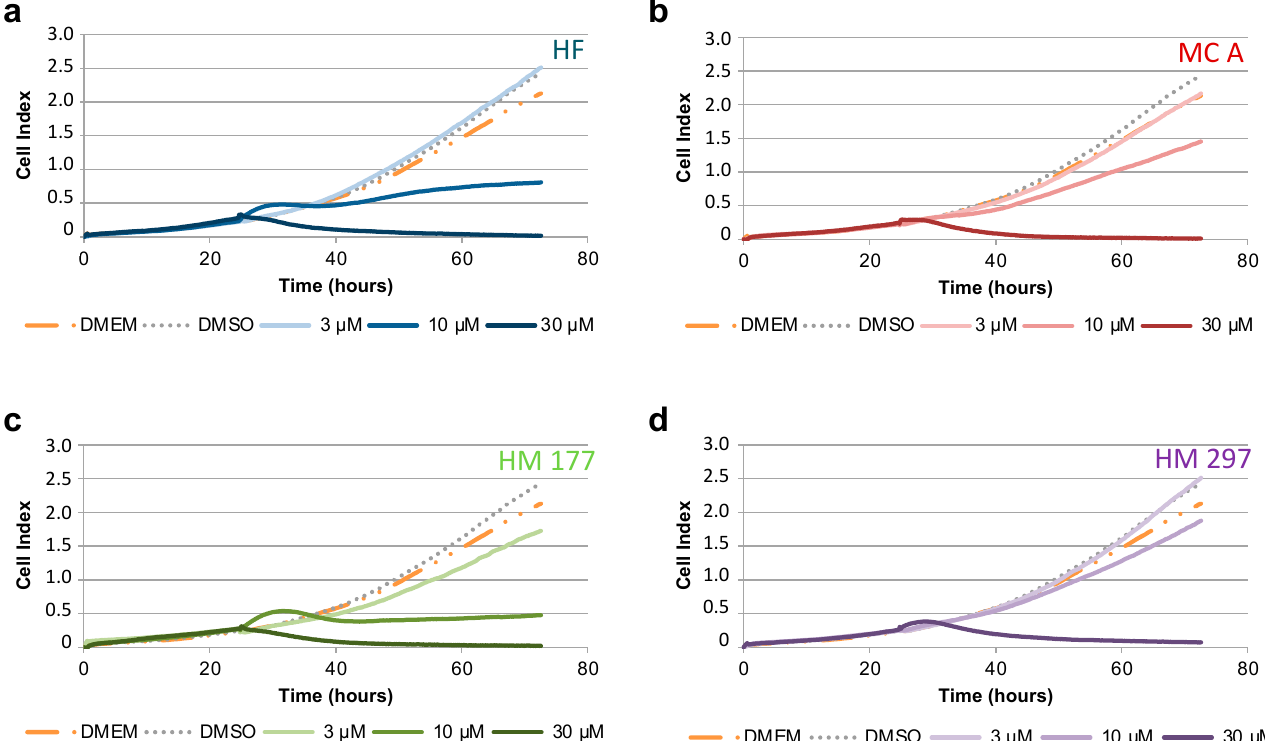
Figure 4. Analysis of cell proliferation of HCT116 cells using real-time impedimetric measurement using the xCELLigence system in response to treatment with the indicated concentrations of ( a ) HF, ( b ) MC A and its derivatives ( c ) HM 177 and ( d ) HM 297. The graphs show representative cell index values of experiments performed in duplicate.